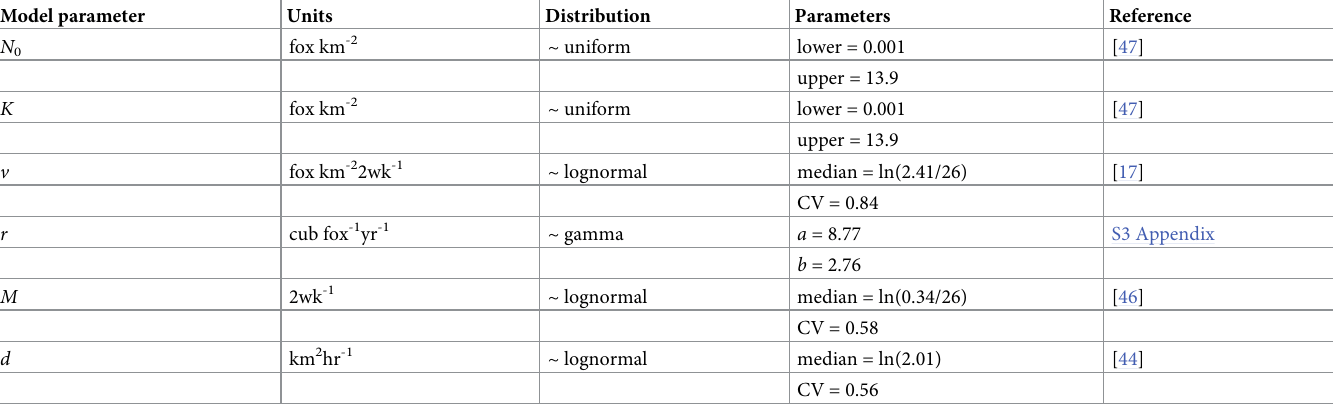
Table 2. Prior probability distributions for estimated model